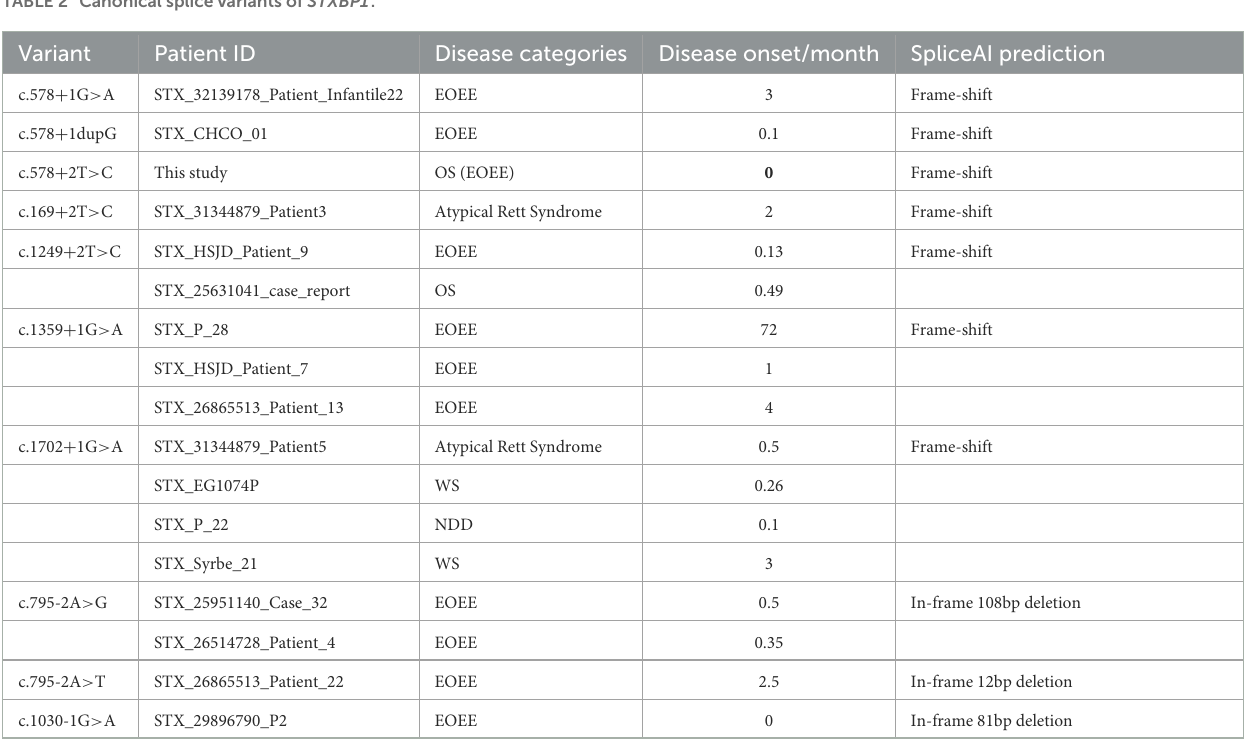
TABLE 2 Canonical splice variants of STXBP1